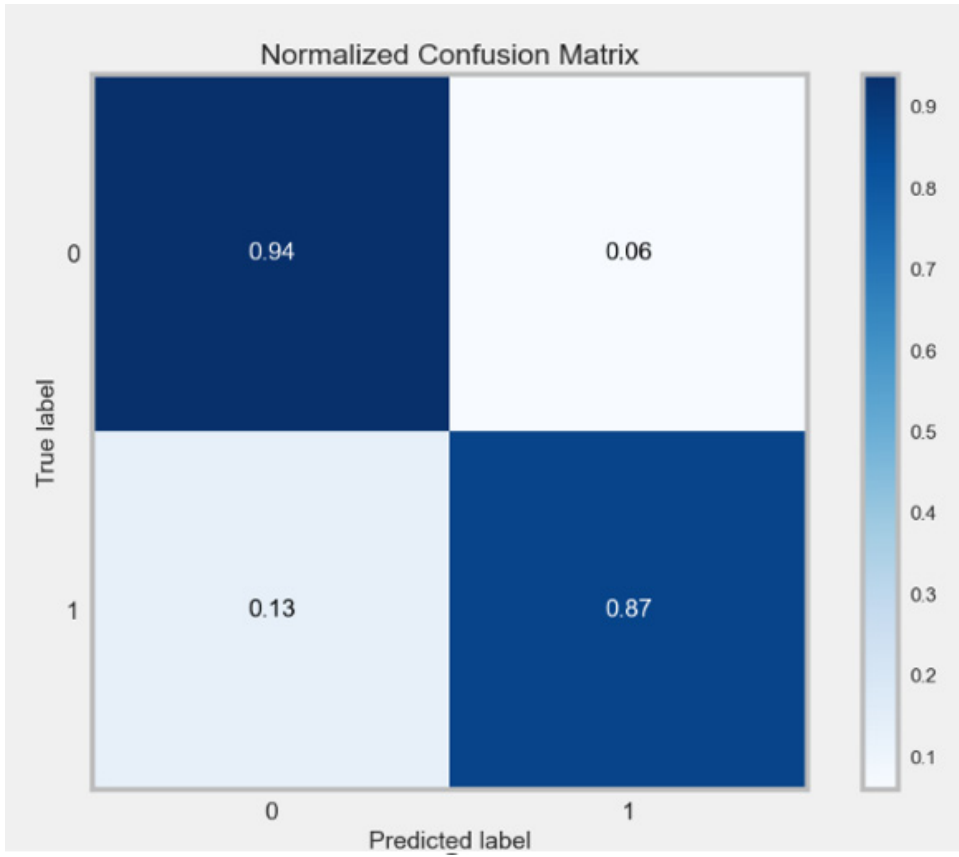
Figure 18. Normalized Confusion matrix for random forest model.